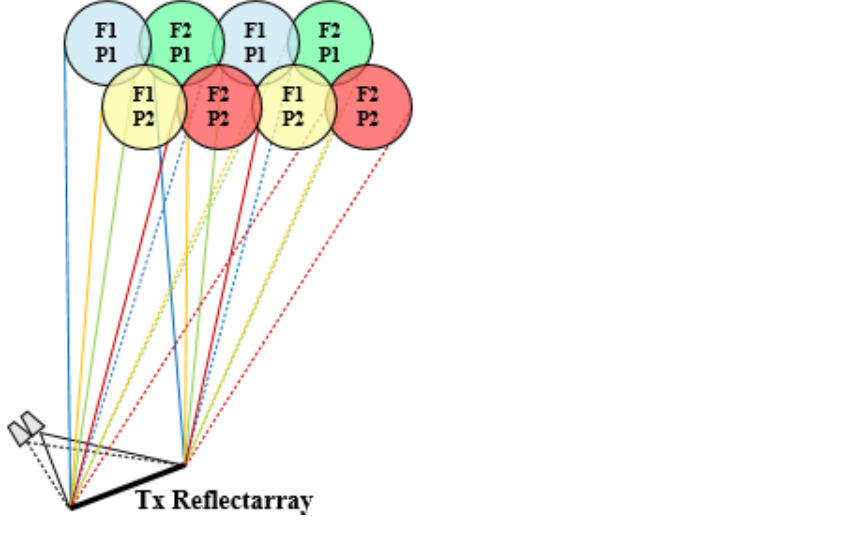
Figure 4. Operating principle of the proposed single-band reflectarray.